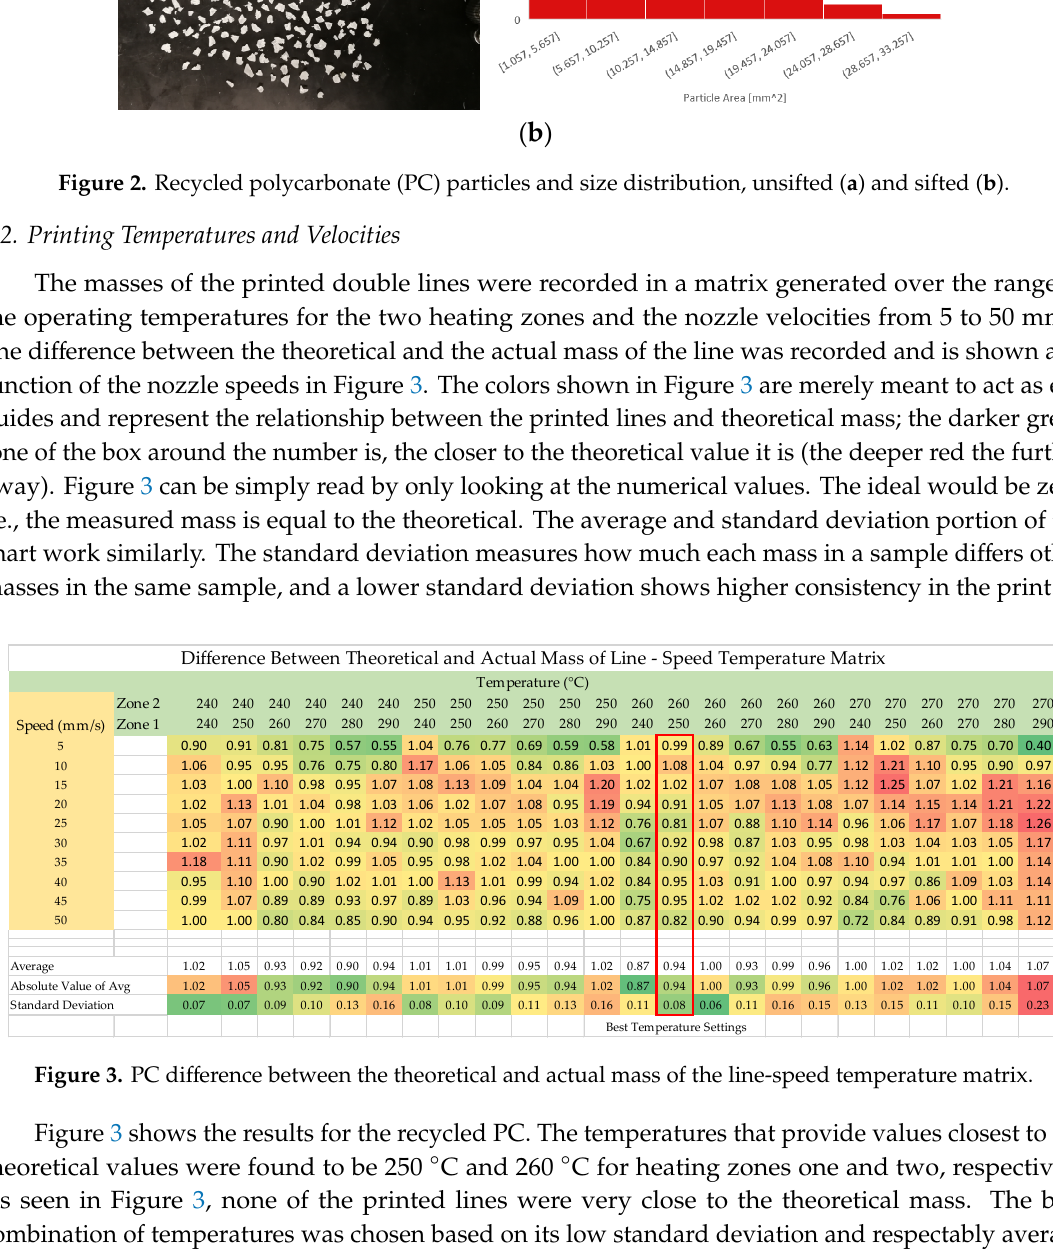
Figure 2. Recycled polycarbonate (PC) particles and size distribution, unsifted ( a ) and sifted ( b ).